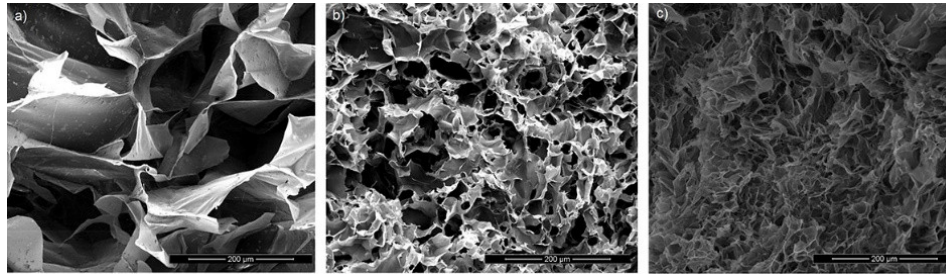
Figure 1. SEM morphology of cryogels: ( a ) P1, ( b ) P2 and ( c ) P3.